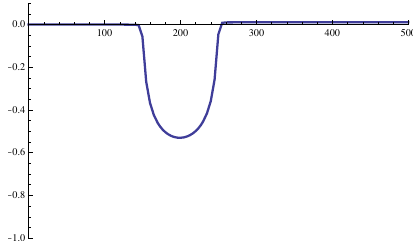
Figure 42 . The ratio (cid:1) S D